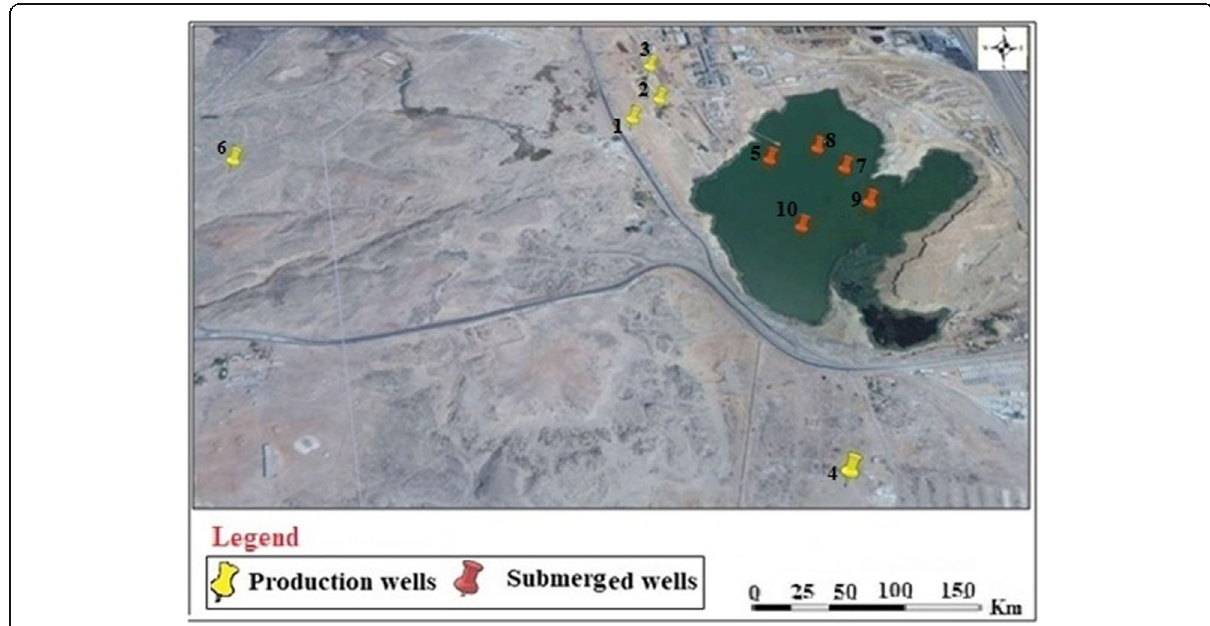
Fig. 3 Location of the groundwater wells (production and submerged wells after